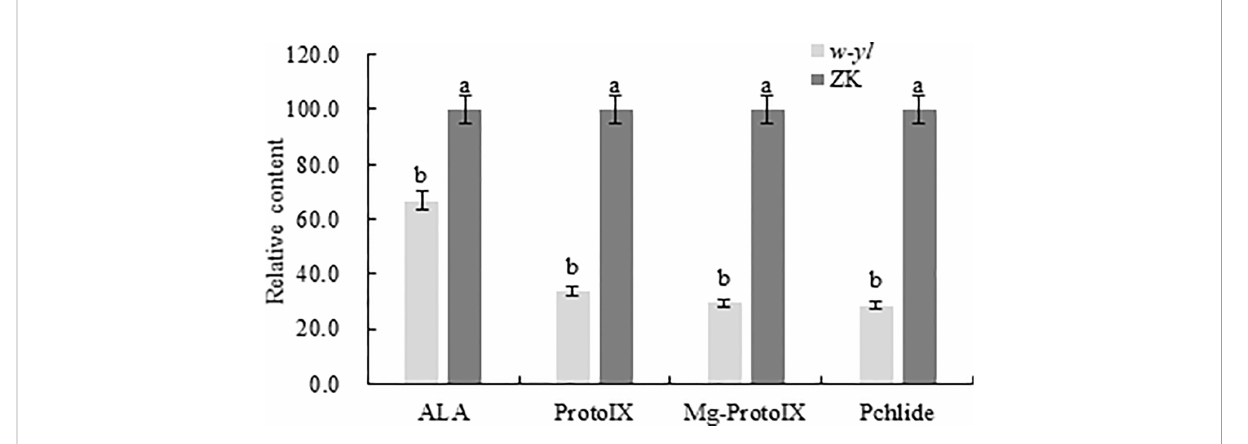
FIGURE 2 Chlorophyll precursors content of the w-yl and CK in pepper leaf. Small letters represent signi fi cant difference at P<0.05.